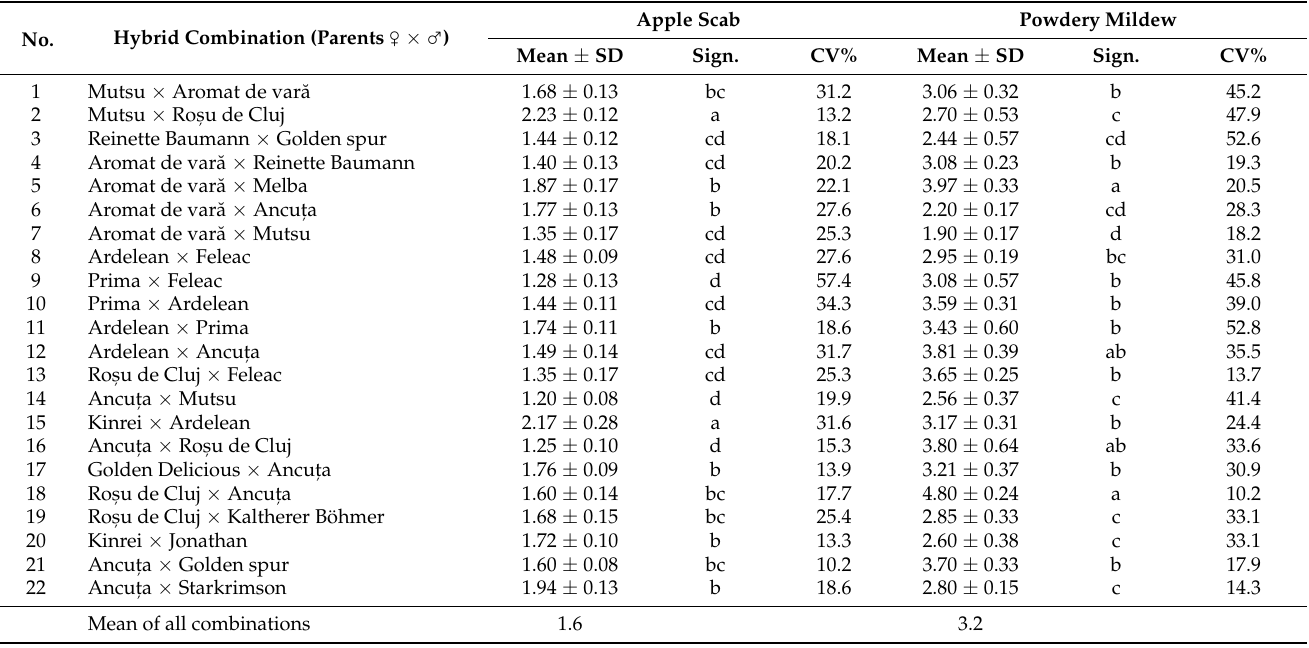
Table 8. Average scores of F 1 apple hybrids from 22 hybrid combinations for apple scab ( Venturia inaequalis ) and powdery mildew ( Podosphaera leucotricha ) attack degree (AD%)